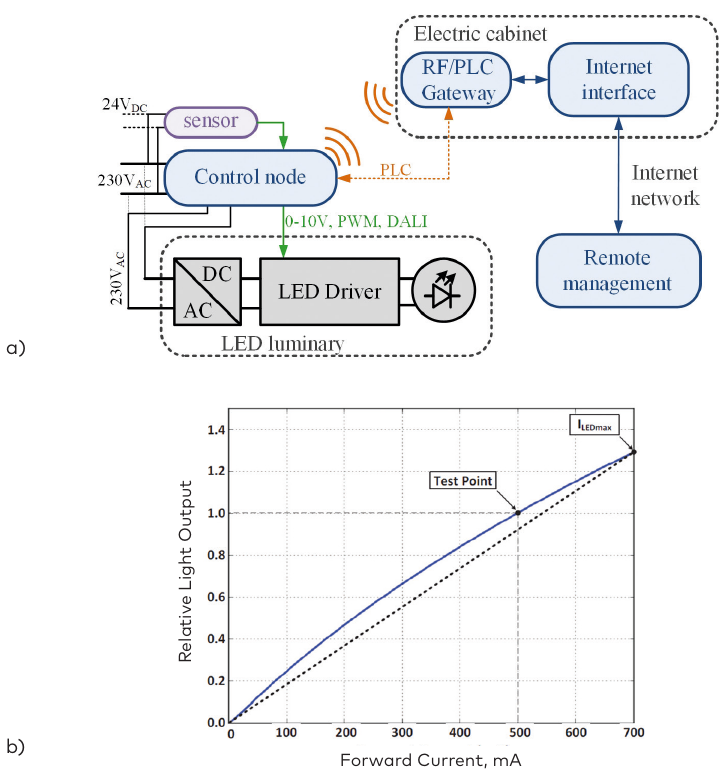
Figure 9. A sample of smart lighting LED luminary (a), and the relation between LED current and light output